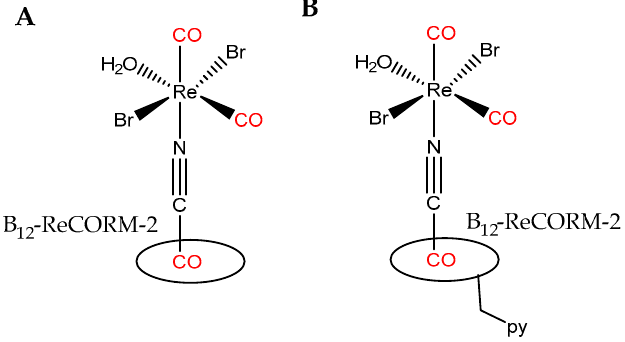
Figure 17. B 12 -Re II (CO) 2 CORMats conjugate: ( A ) B 12 -ReCORM-2; ( B ) B 12 -ReCORM-4.